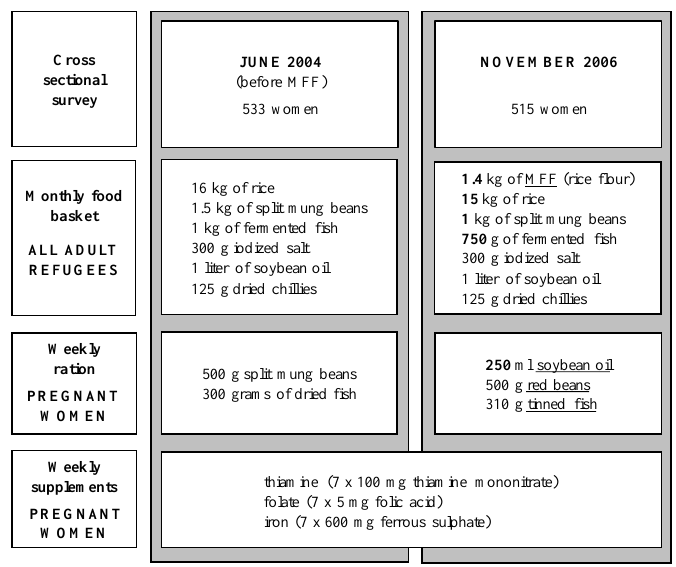
Figure 1. Food rations and supplements by survey. Changes indicated by underline; grey boxes indicate cross-sectional surveys.